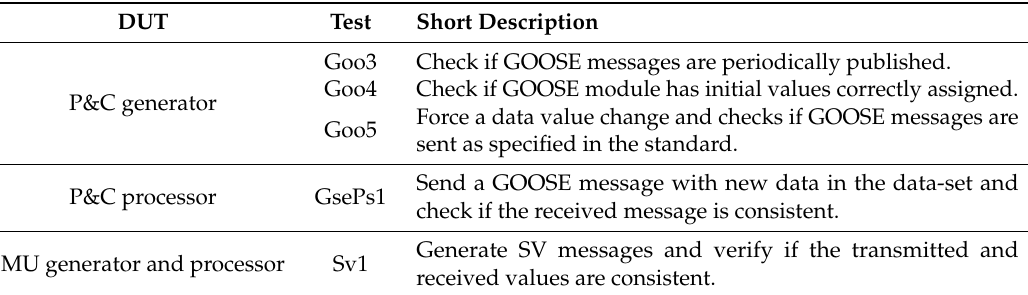
Table A2. Conformance tests for static